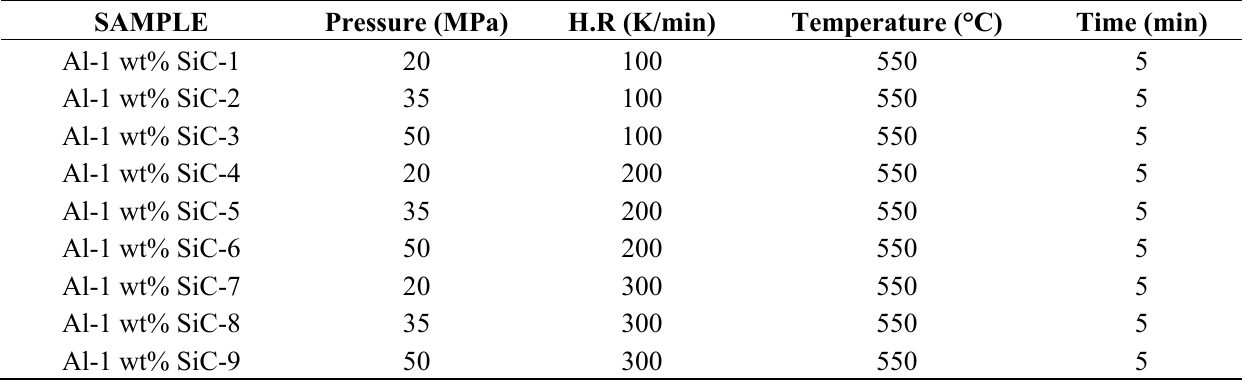
Table 1. Experimental parameters used to investigate the influence of sintering pressure and heating rate.